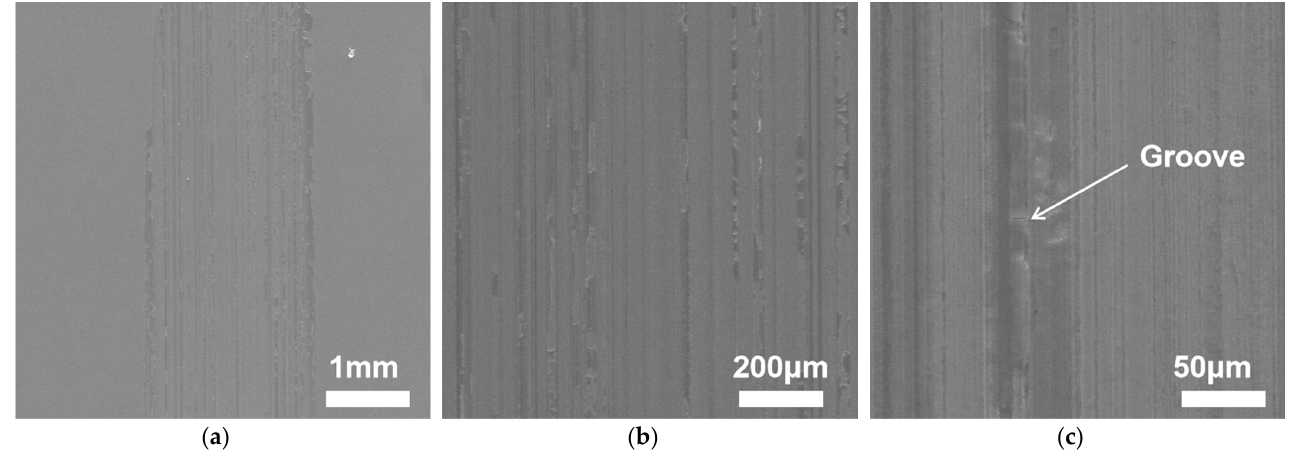
Figure 5. Fe-based alloy coating SEM images. These three images are obtained under different mi- croscopic multiples of the same area. ( a ) Wear marks of Fe-based coating at 1mm of the scale; ( b ) Wear marks of Fe-based coating at 200 μ m of the scale; ( c ) Wear marks of Fe-based coating at 50 μ m of the scale.